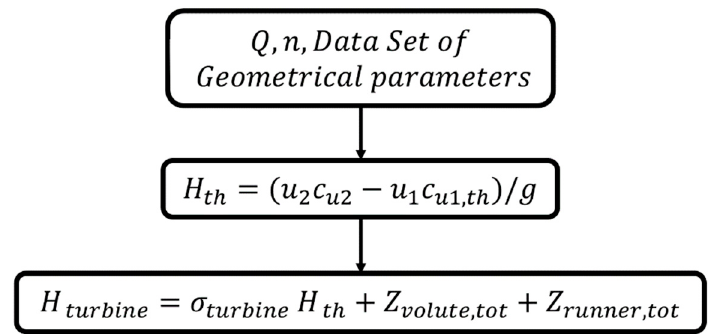
Figure 22. Flow chart of the 1-D proposed model.